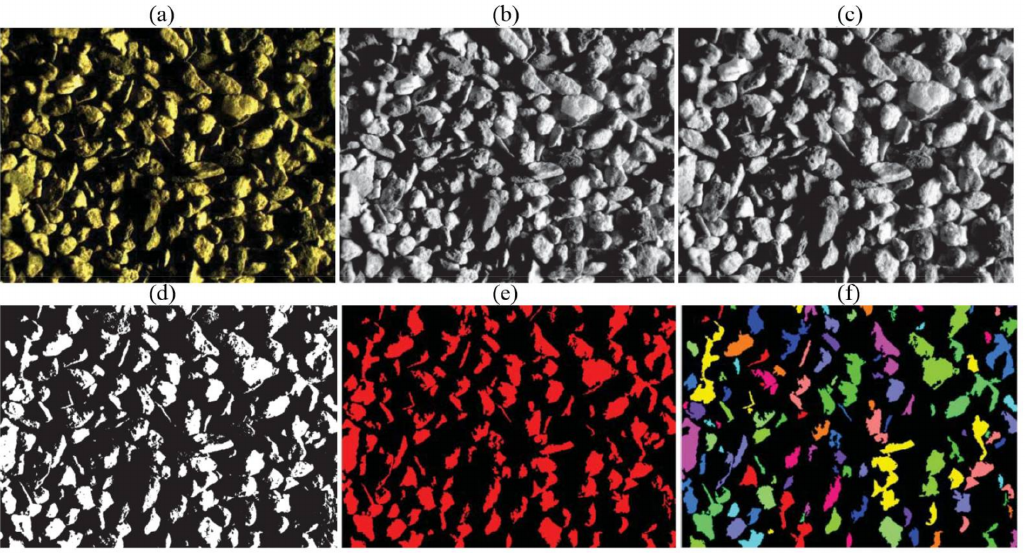
Figure 10. Stages of image processing: ( a ) original image; ( b ) after histogram equalization; ( c ) after extraction; ( d ) after segmentation; ( e ) after refining; ( f ) final